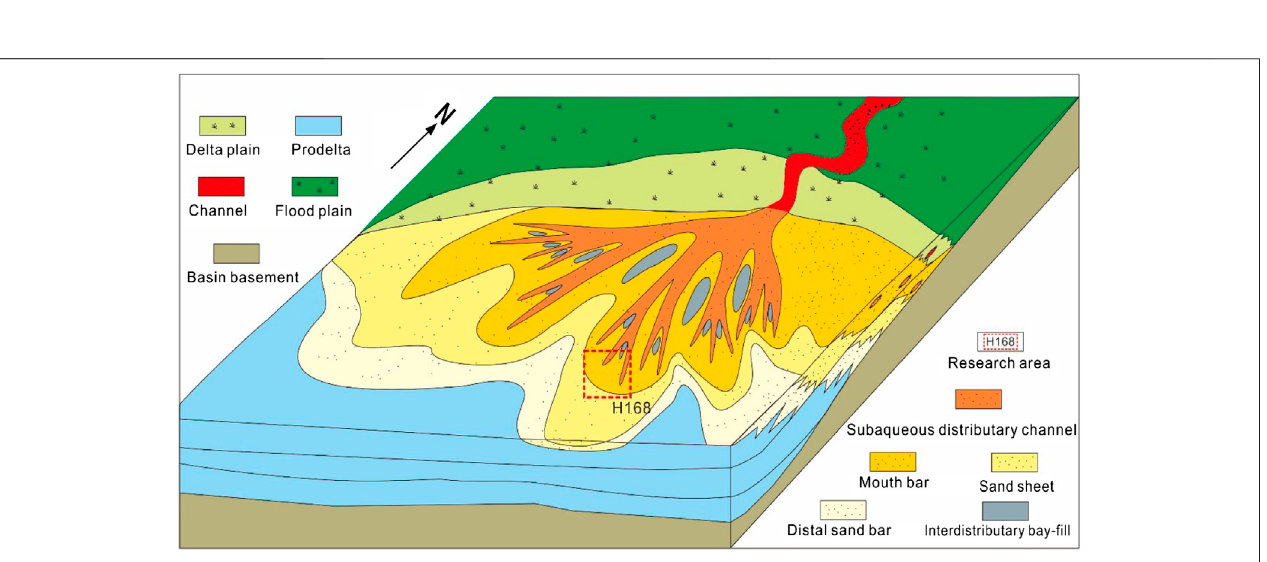
FIGURE 10 | Sedimentary model of river delta (the study area is located in the delta front area).